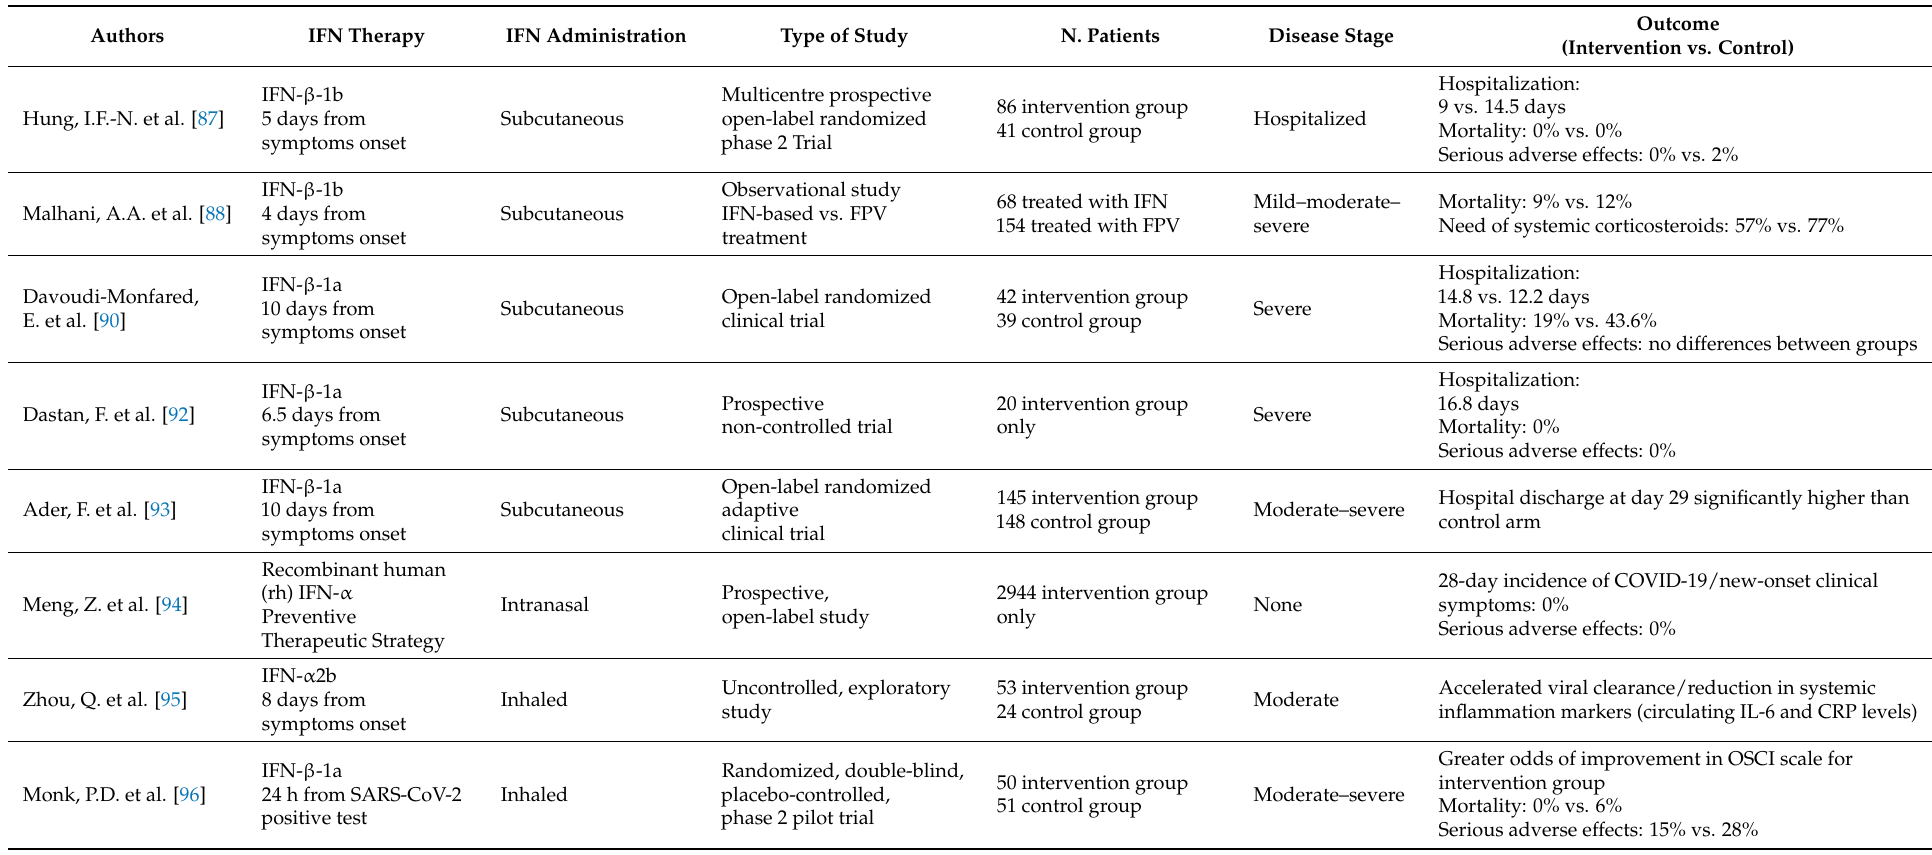
Table 2. IFN-based treatment